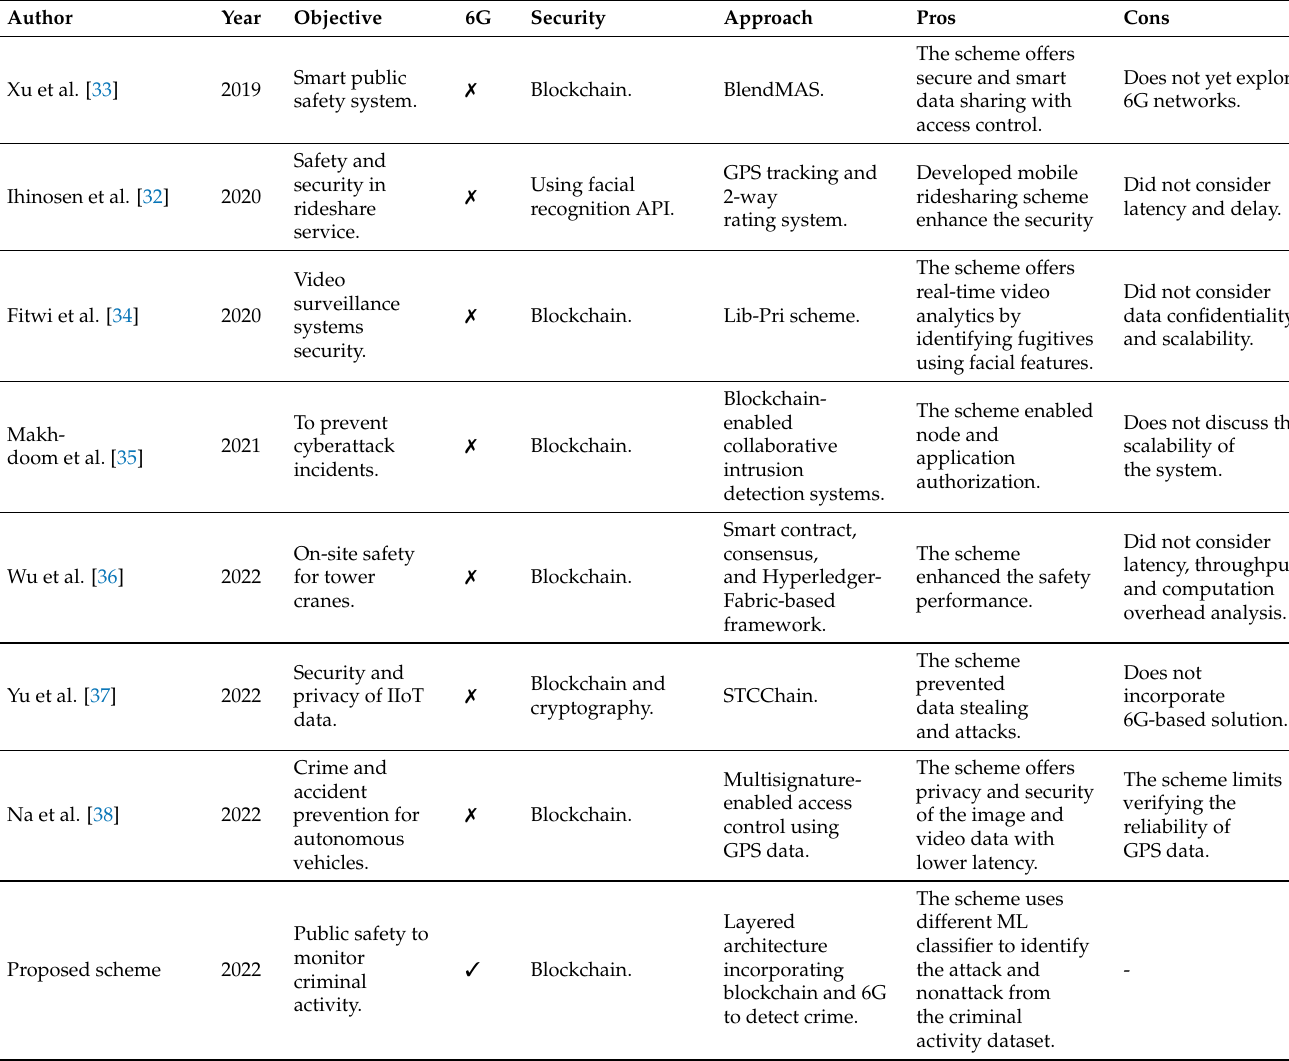
Table 1. A comparative analysis of proposed work with the existing